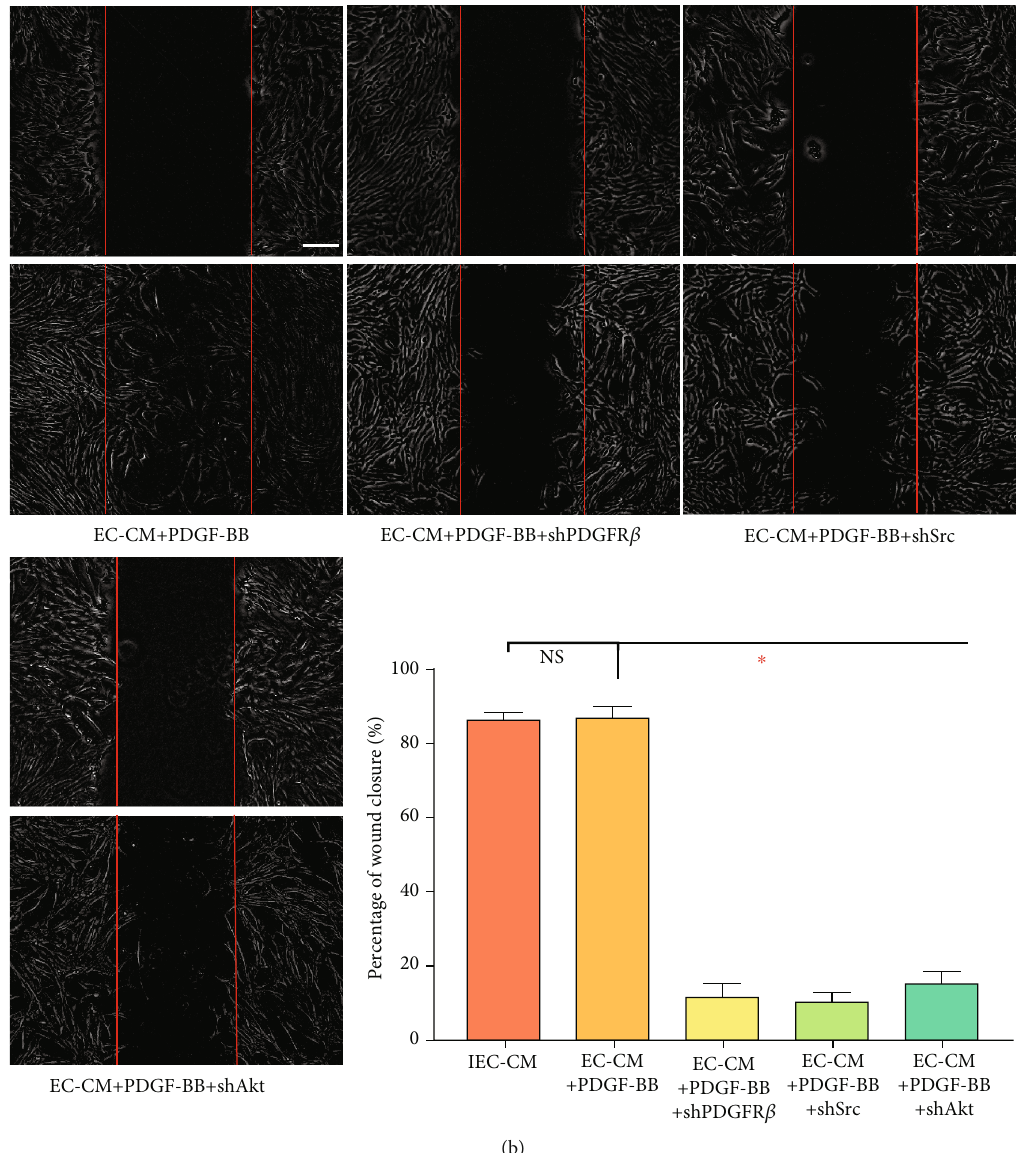
Figure 3: Src and Akt functioned downstream of PDGFR β . (a) Representative images of migrated hBMSCs in Transwell culture systems. The quanti fi cation of migrated cells was shown as a bar graph. Data were compared with the group of IEC-CM from Figure 1. Scale bar, 50 μ m. ∗ P < 0 : 05 . (b) Representative images of wound healing assays. The rate of scratch wound closure was shown as a bar graph. Data were compared with the group of IEC-CM from Figure 1. Scale bar, 200 μ m. ∗ P < 0 : 05 . IEC-CM: conditioned media of endothelial cells in the context of in fl ammatory microenvironment; shPDGFR β : short hairpin RNA targeting pdgfrb ; shSrc: shRNA targeting src ; shAkt: shRNA targeting akt